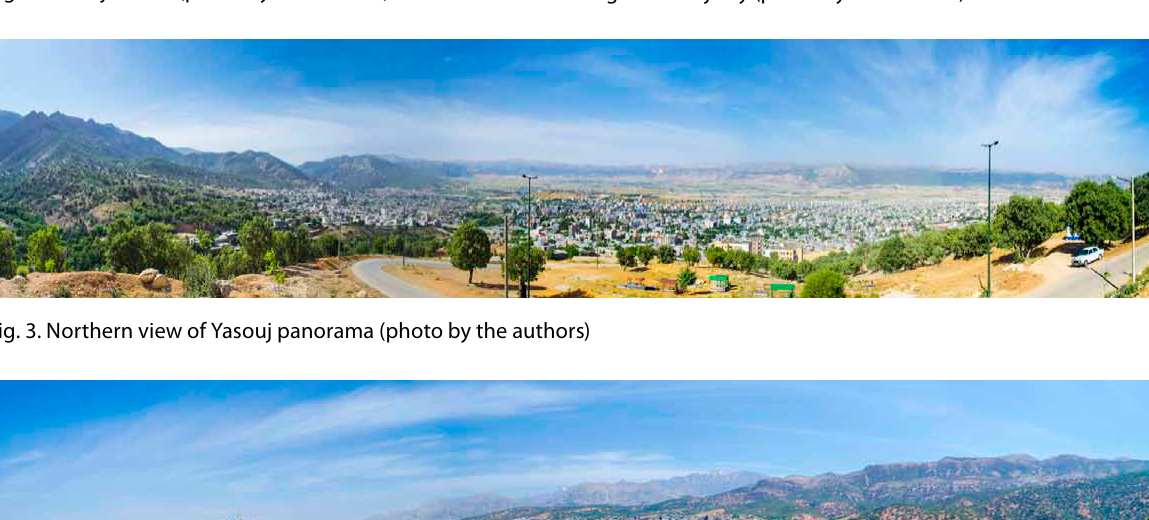
fig. 1. Yasouj nature (photo by the authors) fig. 2. Yasouj city (photo by the authors)